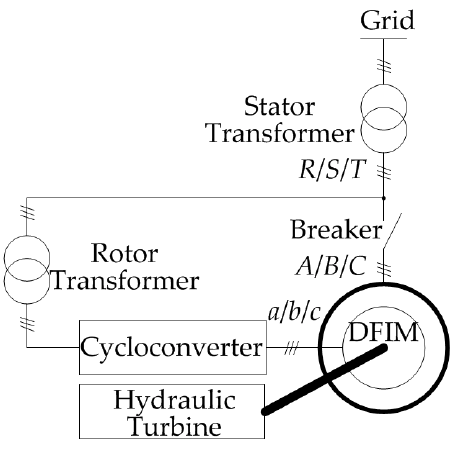
Figure 1. Schematic diagram of the adjustable-speed, pumped-storage hydropower plant.